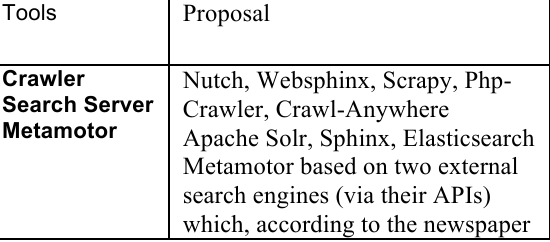
Table 1. Choice of tools and methods